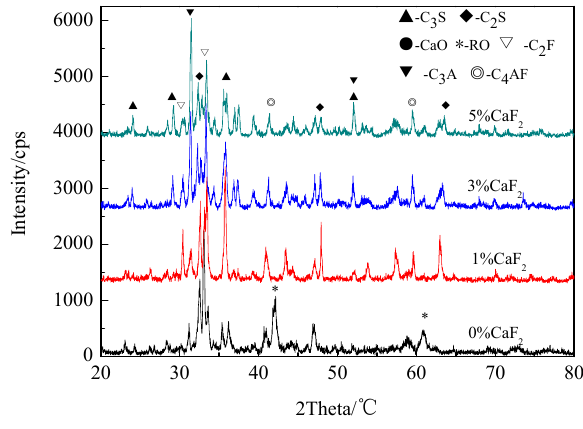
Figure 6: XRD patterns of reconstructed steel slag with different CaF 2 contents.